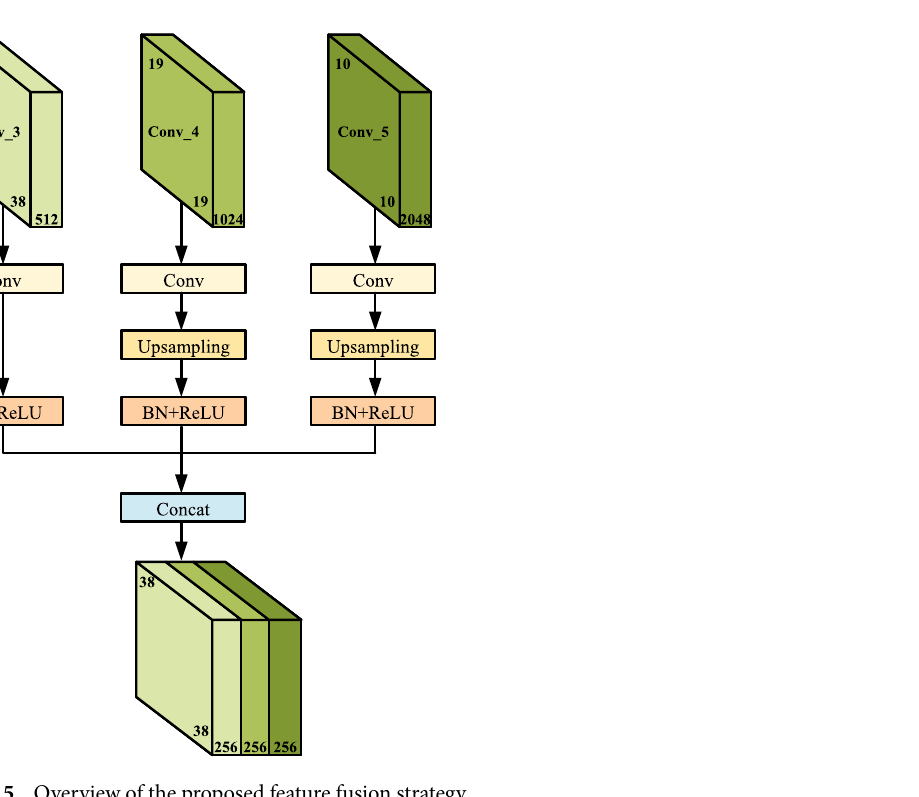
Figure 5. Overview of the proposed feature fusion